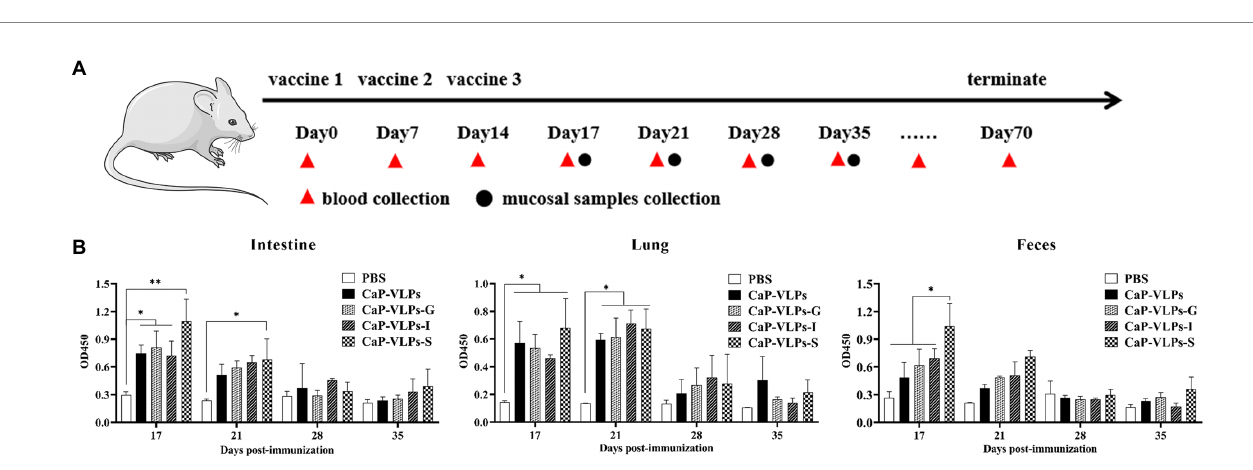
FIGURE 2 Immune responses of regional mucosal sites elicited by CaP-VLPs. (A) Overview of the immunization schedule. (B) BALB/c mice ( n = 20/group) were immunized with CaP-VLPs with or without adjuvant three times on days 0, 7, and 14. IgA in the intestines, lung, and feces of mice was monitored by indirect ELISA. Asterisks indicate significant differences (* p < 0.05, ** p <